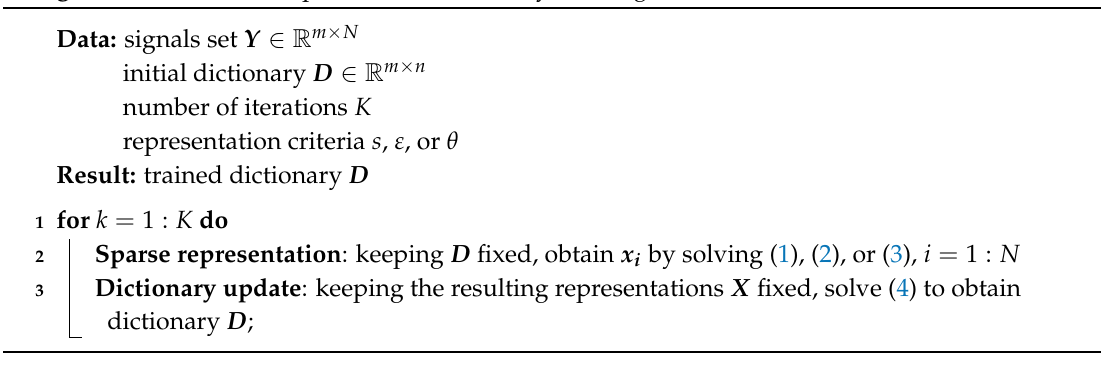
Algorithm 1: Alternate optimization dictionary